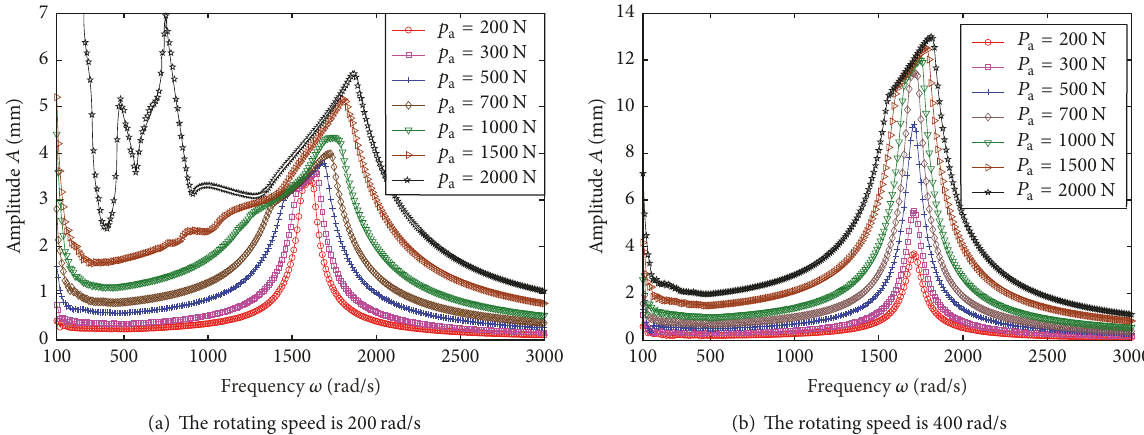
Figure 9: The amplitude-frequency response curves at different excitation amplitudes.